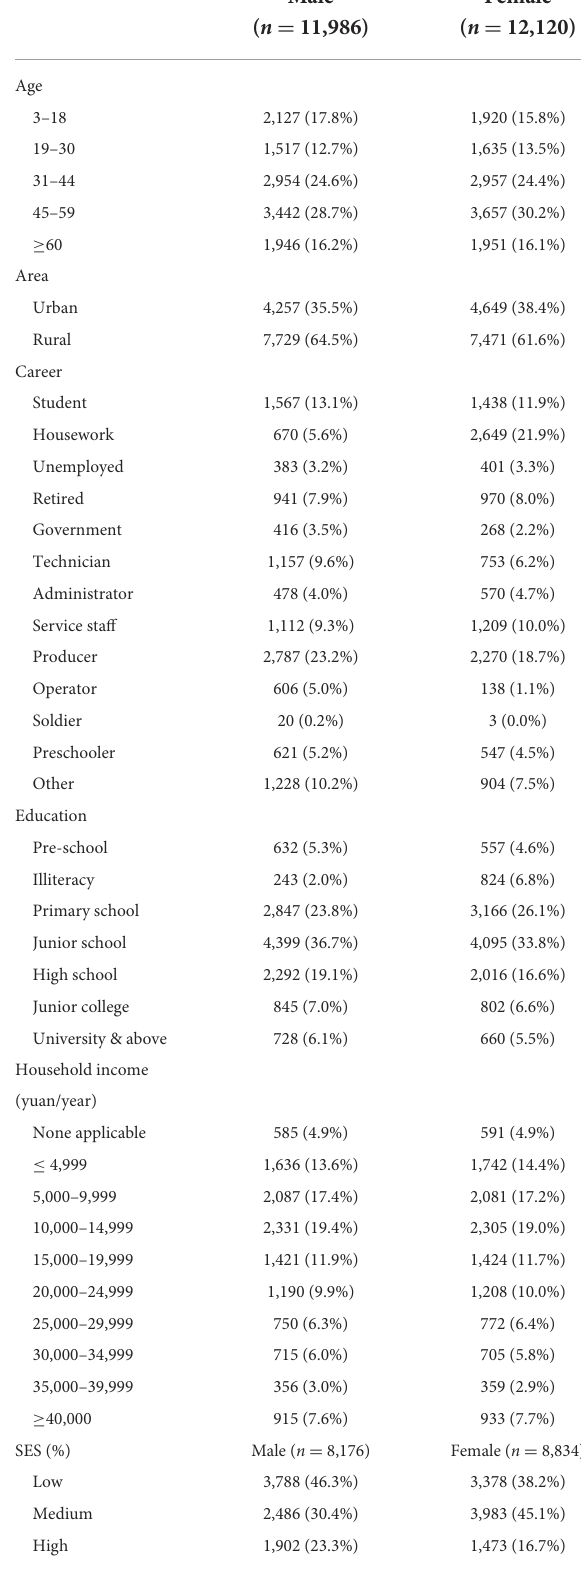
TABLE 1 Characteristics of the participants in the retrospective dietary interview ( n =